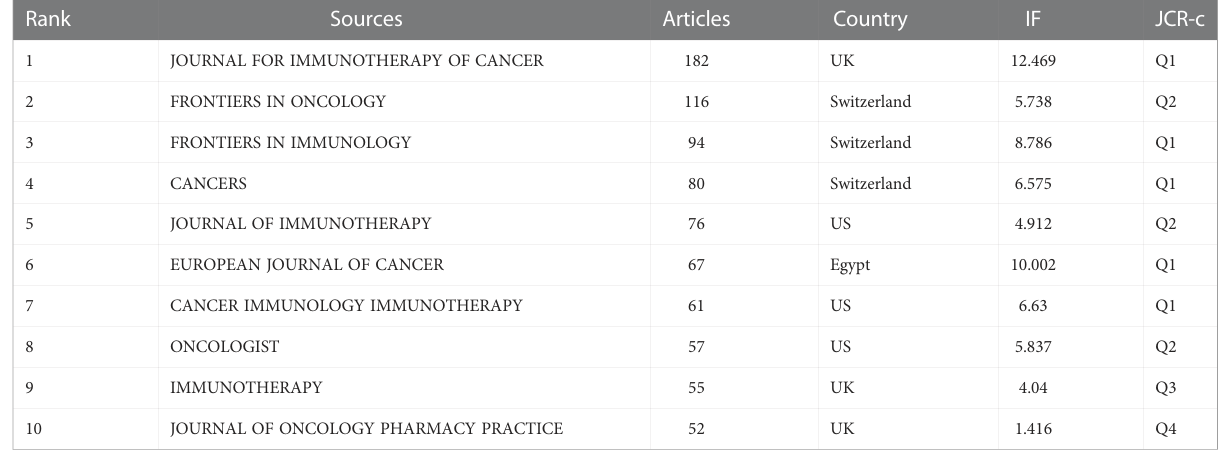
TABLE 1 Top 10 journals with most publications in the fi eld of immune-related adverse